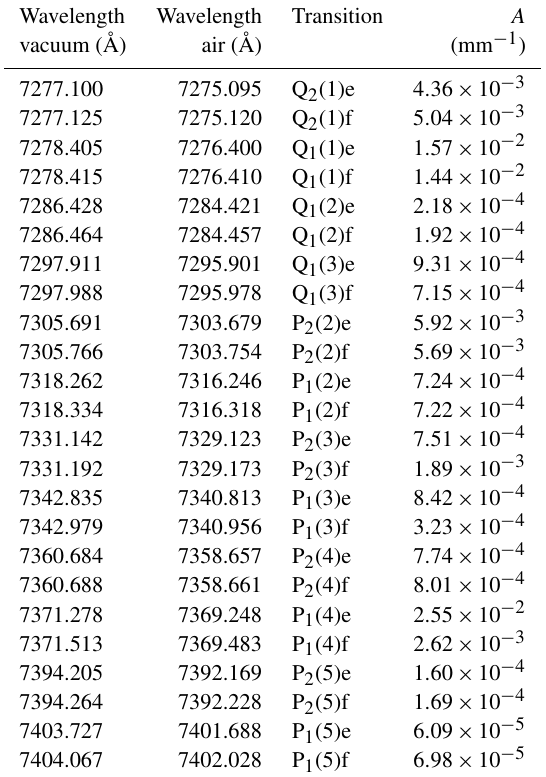
Table 1. Water vapour transmission at wavelengths of OH(8–3) lines. Vacuum wavelengths are from Rousselot et al. (2000), with conversion to air wavelengths undertaken as specified by Ciddor (1996). At each wavelength, water vapour transmission is given by a function of precipitable water vapour (PWV): T λ = exp ( − A × PWV ) , with PWV in mm.